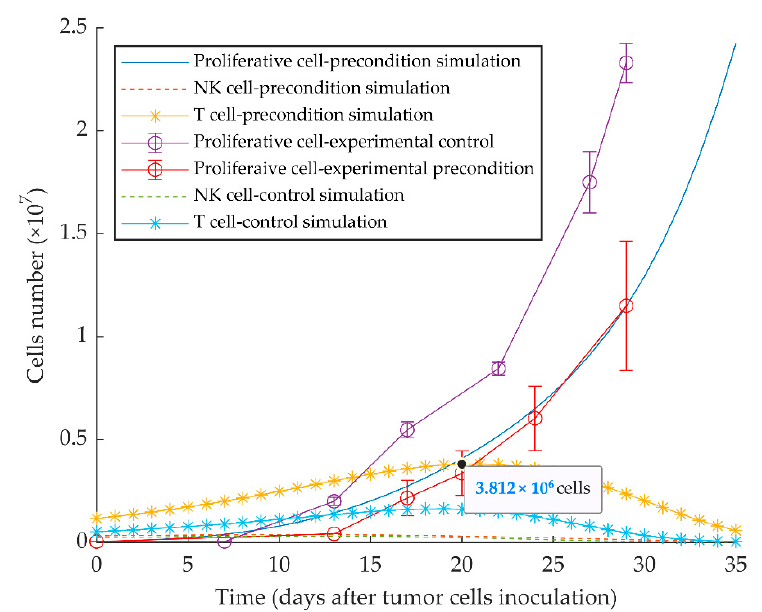
Figure 6. Mathematical simulation of aggressive tumor growth delay by preconditioning of mice with dormant tumor cells. By simulating the injection of 5 × 10 4 quiescent tumor cells 10 days before injecting the same number of proliferative tumor cells on day 0, the simulation shows increased stimulation of CD8 + T cells and subsequent delayed tumor growth. Experimental data are from Reference [51] and are represented as mean ± SEM.